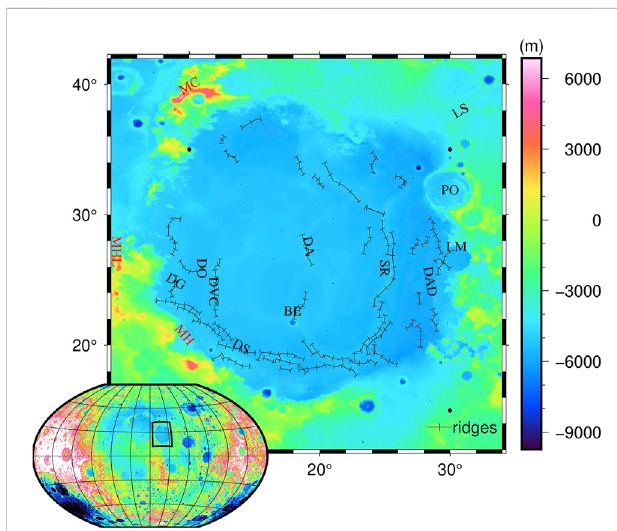
FIGURE 1 Topography of the Mare Serenitatis. MC, montes caucasus: MHL, monshadley;MH,monteshaemus;DA,dorsumazara;DVC,dorsumvon cotta; DG, dorsum gast; DS, dorsa sorby; SR, serpentine ridge; DO, dorsum owen; DAD, dorsa aldrovandi; BE, bessel; LM, le monnier crater; LS, somniorum; PO, posidonius. The black lines with bars represent lunar